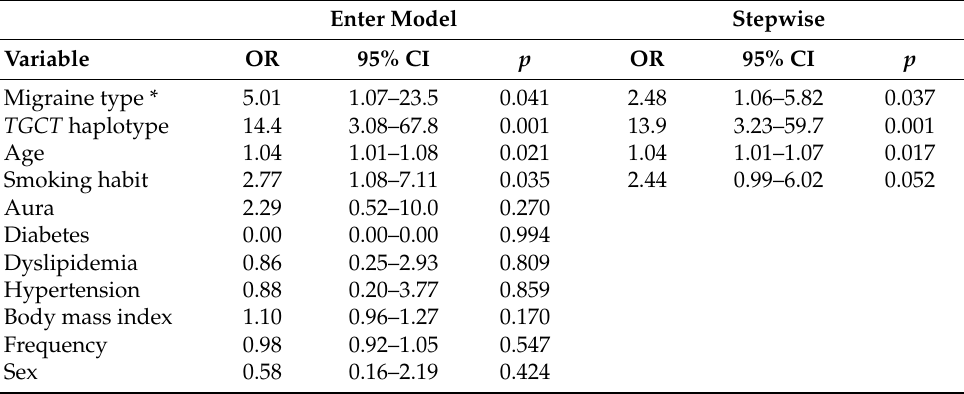
Table 5. Logistic regression analysis of independent determinant of white matter hyperintensities (WMHs) in migraine